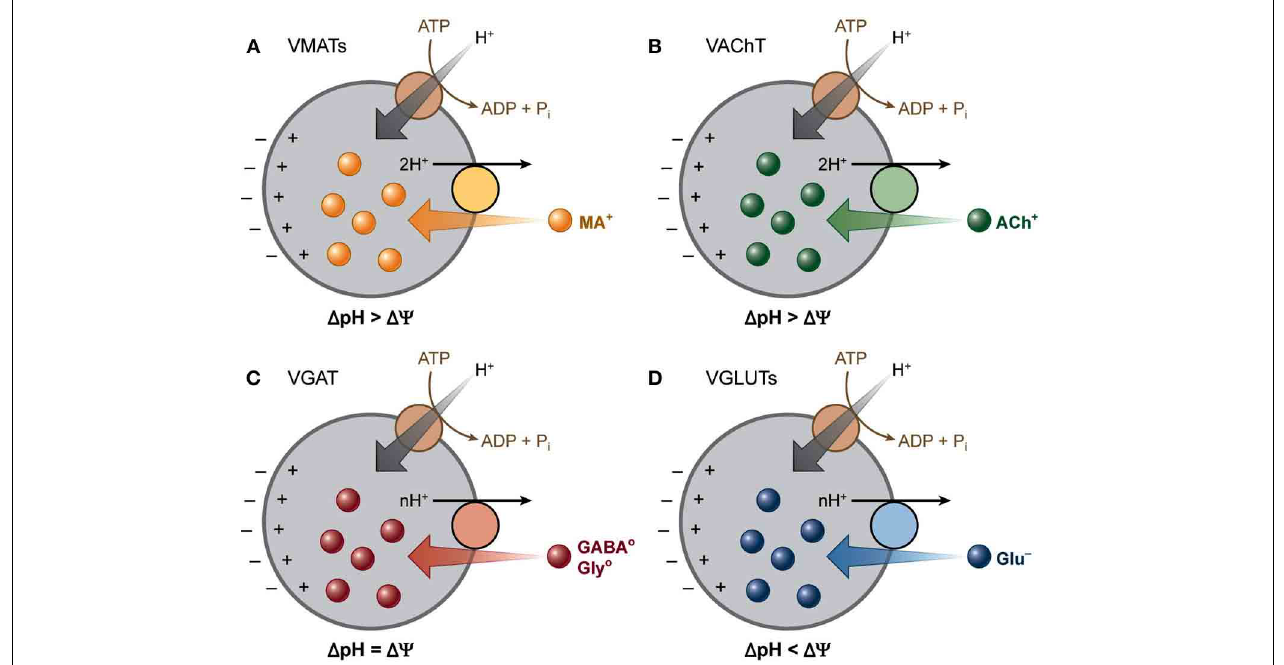
( (cid:2) pH and (cid:2) ψ ) of this gradient. (A) VMATs and (B) VAChT transport their positively charged substrates coupled to the exchange of two H + , and hence rely primarily on (cid:2) pH. (C) GABA and glycine are transported as neutral zwitterions by VGAT, which depends equally on both the chemical and the electrical component of (cid:2) μ H + . (D) VGLUTs transport the negatively charged glutamate and thus rely more on (cid:2) ψ than (cid:2) pH. [Modified from Chaudhry et al. (2008b) with